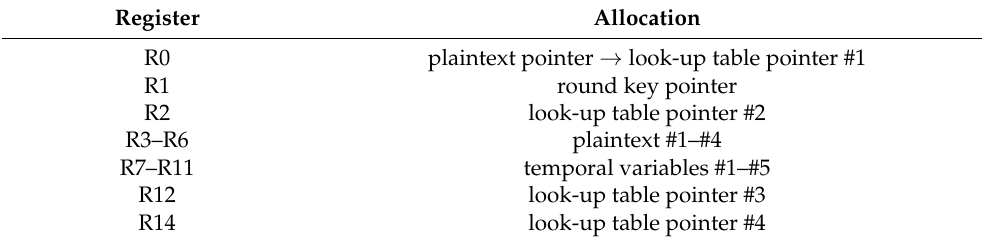
Figure 2. The 8 × 32 table look-ups for ARIA block cipher on ARM Cortex-M3. 1 (cid:13) : LUT access with 25–32-th bits, 2 (cid:13) : LUT access with 17–24-th bits, 3 (cid:13) : LUT access with 9–16-th bits, 4 (cid:13) : LUT access with 1–8-th bits, 5 (cid:13) : XOR operations with LUT results. Table 4. Register allocation for ARIA encryption on ARM Cortex-M3 processors.